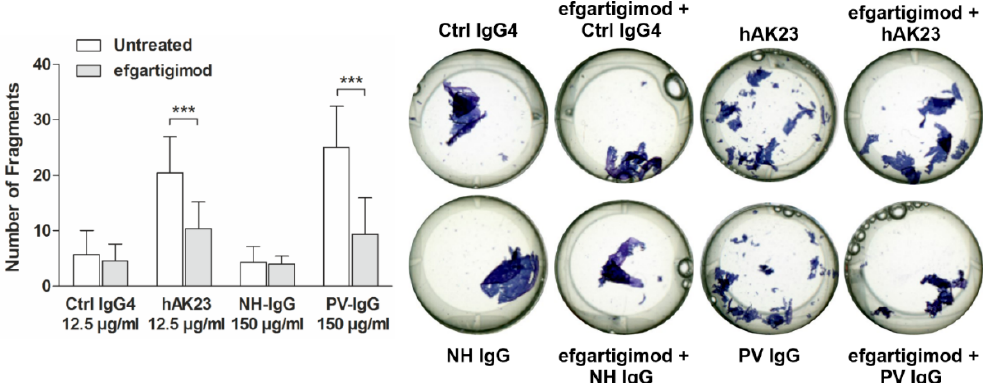
Figure 5. Efgartigimod treatment protects keratinocyte monolayers against dissociation induced by PV IgG. hTert keratinocytes were plated on 24-well plates, grown in KGM2 medium with 0.05 mM CaCl 2 until confluent, and then switched to KGM2 with 2 mM CaCl 2 for 24 h. The cells were left untreated, or efgartigimod (25 µg/mL) was applied for 30 min prior to the 24 h treatment with hAK23 (12.5 µg/mL), control IgG4 (12.5 µg/mL), PV IgG (150 µg/mL) or human control IgG (150 µg/mL). Monolayer dissociation assay was performed in triplicates, and the number of fragments was quantified using ImageJ software. A representative experiment is shown. The error bars show the SD of the mean values obtained from five independent experiments. Statistical analysis was done using two-way ANOVA with Bonferroni’s post-test. Statistically significant differences are indicated by *** = p ≤ 0.001.